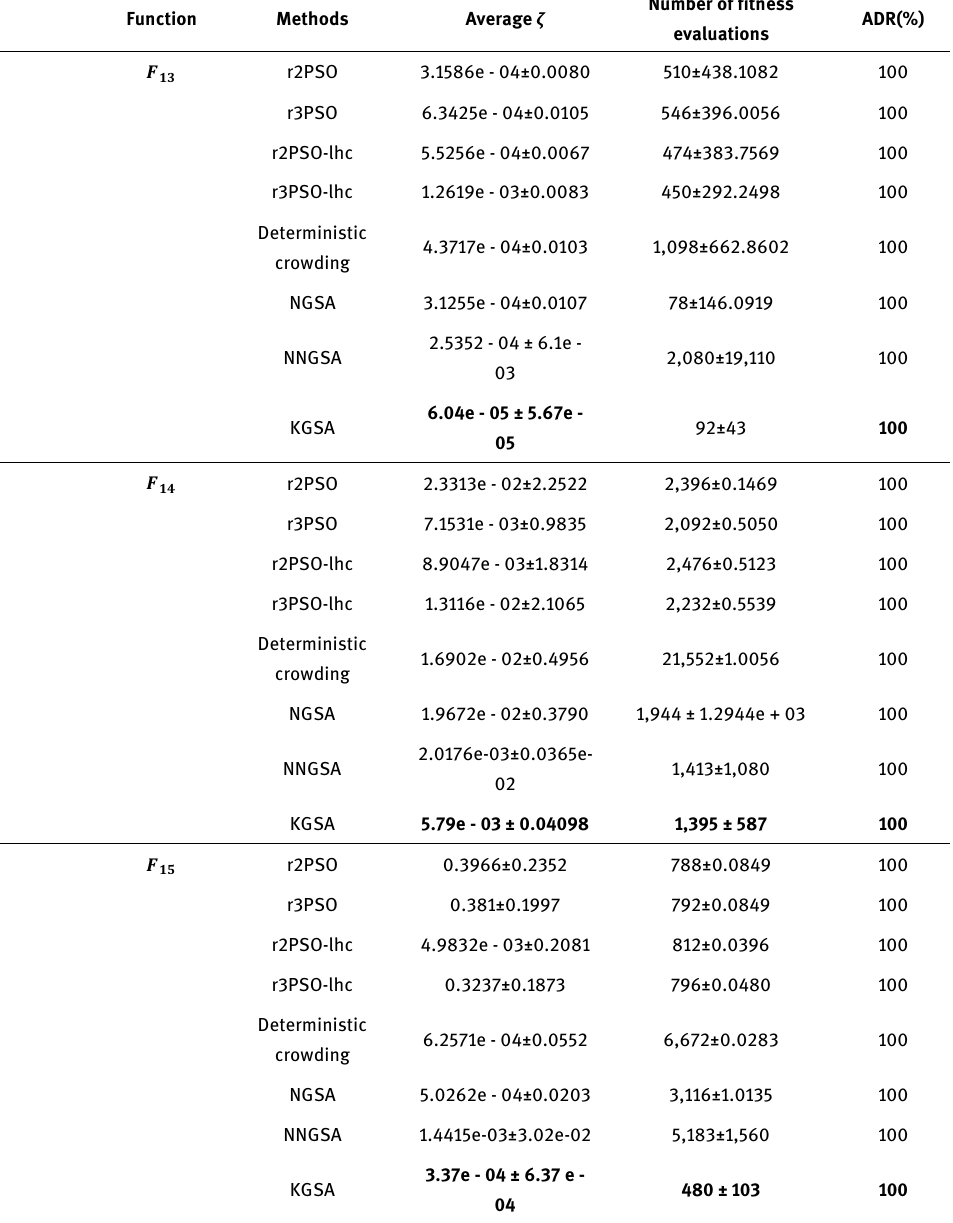
Table 10: Performance comparison when constrained test functions were